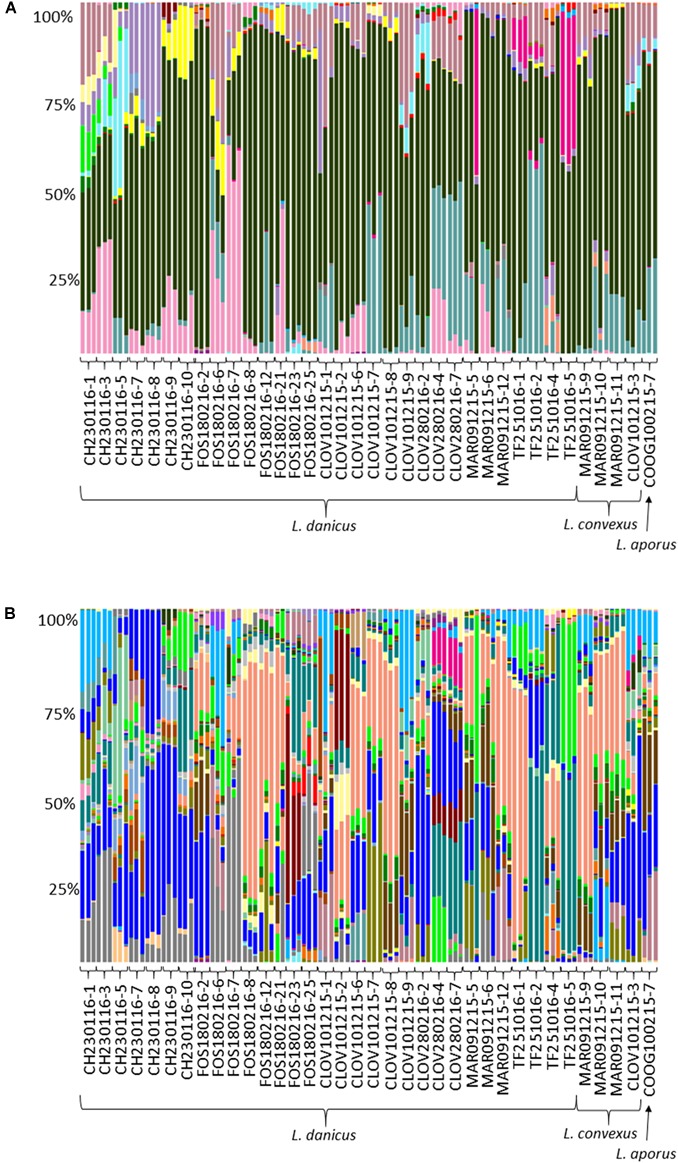
Comparative sequence analysis of normalized (15000 rarefaction) 16S ribosomal RNA (rRNA) gene libraries from all diatom strains. Each strain has three replicates with the exception of strain FOS180216-21, for which only 2 of 3 replicates yielded enough DNA for downstream processing. (A) Relative percent abundance at OTU level; ∼58% were made up of Roseovarius 18% (coral); Rhodobacteraceae; Ambiguous taxa 17.1% (bright blue); Rhodobacteraceae, uncultured sp. 7% (aqua); Owenweeksia 5.5% (gray); Haliea 5% (light blue); Donghicola 4.6% (brown); and (B) relative percent abundance at family level; ∼95% of all sequences were made up of eight families Rhodobacteraceae 60.6% (black); Flavobacteriaceae 10.4% (turquoise); Halieaceae 7.3% (dark pink); Cryomorphaceae 6.7% (pale pink); Alteromonadaceae 3.9% (purple); Erythrobacteraceae 2% (yellow); Pseudoalteromonadaceae 2% (bright pink); and Sphingomonadaceae 1.9% (light blue).